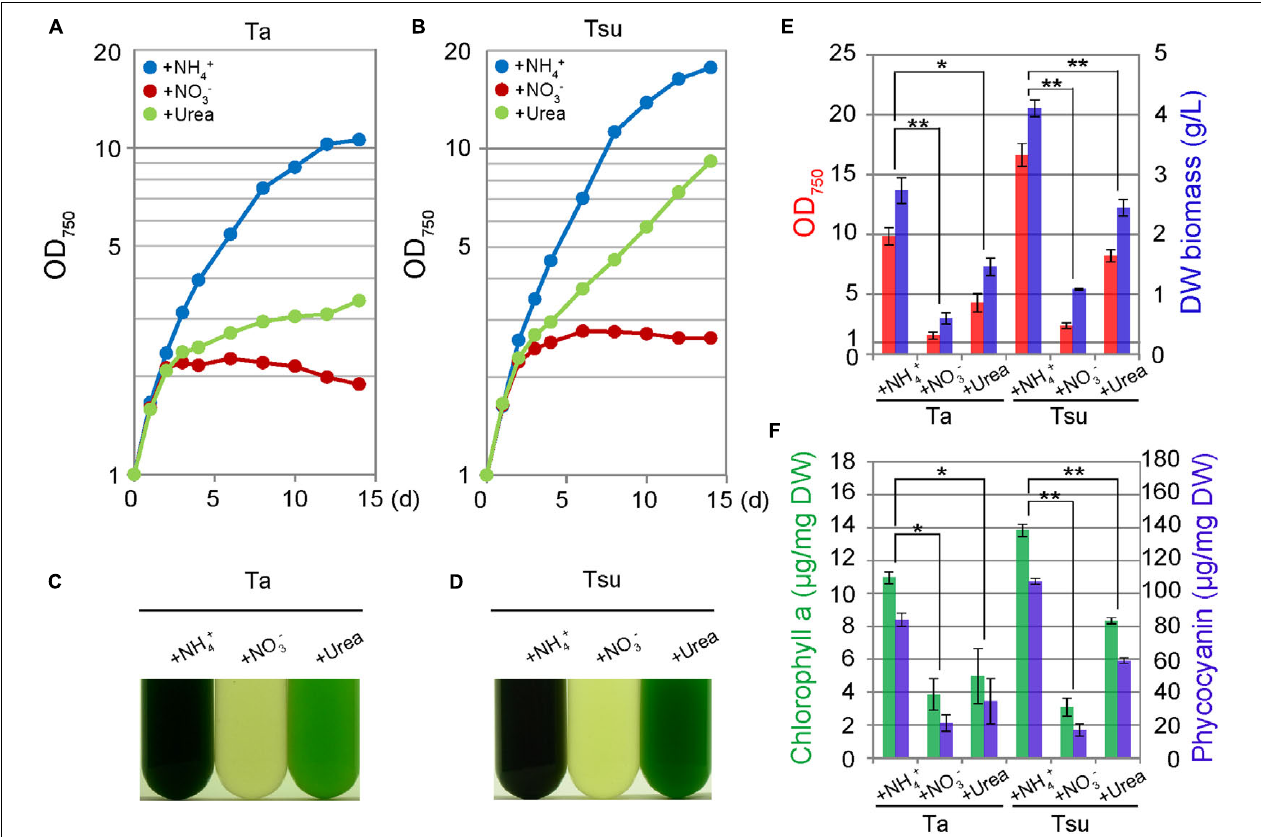
FIGURE 3 | Growth of G. sulphuraria cells in media derived from acidic hot spring waters with different nitrogen sources. Cells cultured in synthetic MA medium (OD 750 of 1.0–2.0) were collected by centrifugation, resuspended into the respective media to give an OD 750 of 1.0 and then cultured for 14 days. (A–D) Change in OD 750 (A,B) and photographs (C,D) of the cultures in the respective media. Photographs were taken 14 days after the inoculation. (E,F) OD 750 (red bar), algal dry weight (DW biomass; blue bar) (E) chlorophyll a (green bars) and phycocyanin (blue bar) contents per algal dry weight (F) at 14 days after the inoculation. Three independent experiments showed similar results and the results from one experiment are shown (A–D) . The bars indicate the standard deviation of three indipendent experiments (E,F) . Significance was calculated by t -test. ∗ Statistically significant differences at P < 0.05; ∗∗ Statistically significant differences at P < 0.01 (E,F)